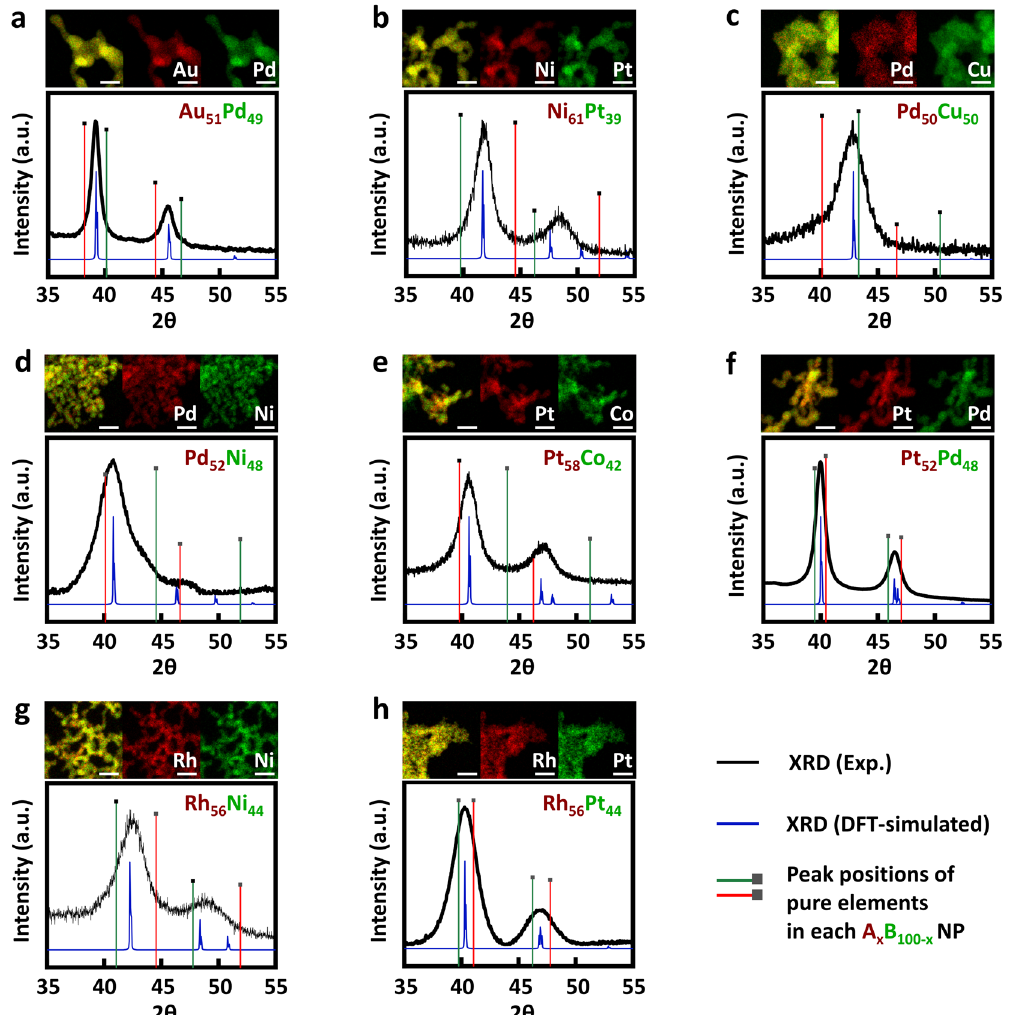
Fig. 4 Characterizations of the synthesized bimetallic NPs. XRDs for a Au 51 Pd 49 , b Ni 61 Pt 39 , c Pd 50 Cu 50 , d Pd 52 Ni 48 , e Pt 58 Co 42 , f Pt 52 Pd 48 , g Rh 56 Ni 44 , h Rh 56 Pt 44 NP samples. For comparison, the red and green lines in the XRD patterns correspond to the peaks of pure elements in each bimetallic NP. The blue peaks were simulated with the crystal structures of the bimetallic system predicted by DFT calculations. Above each XRD pattern, the element mapping images acquired by STEM-EDX are included, where the fi rst image (the most left) is the overlay image of the maps for elements in each bimetallic NP. The scale bars correspond to 20 nm. The enlarged images of the STEM-EDX are also provided in Supplementary Figures